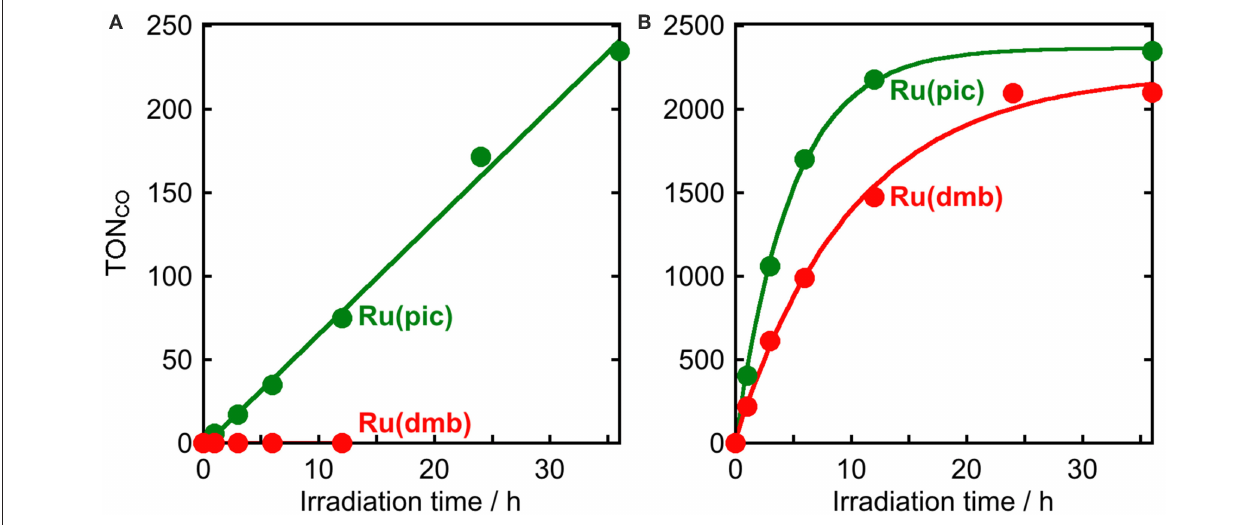
• • ) or Ru(dmb) ( ) as a photosensitizer: CO 2 -saturated DMA-TEOA